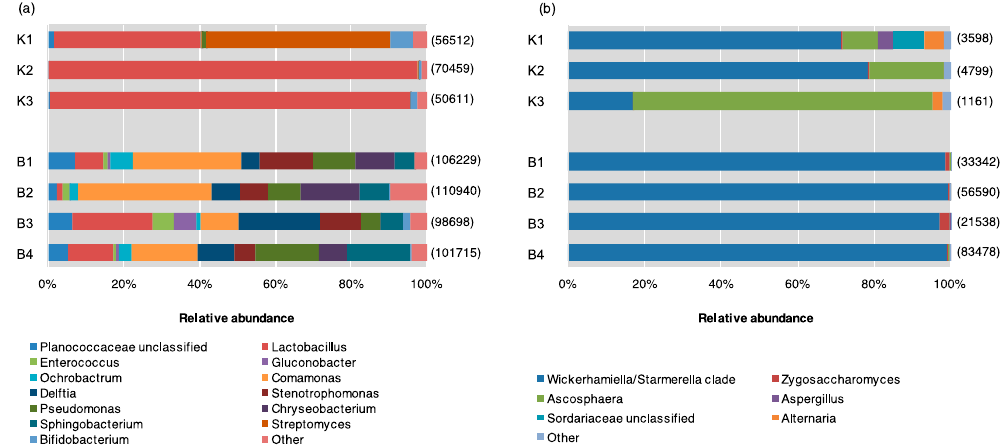
Figure 2. Relative abundance of ( a ) bacterial and ( b ) fungal genera within pollen provisions of indoor–reared bumble bee colonies from Source K ( N = 3), and Source B ( N = 4). Sequences belonging to different microbial genera are shown in different colors. The total number of sequences isolated is displayed to the right of each library.